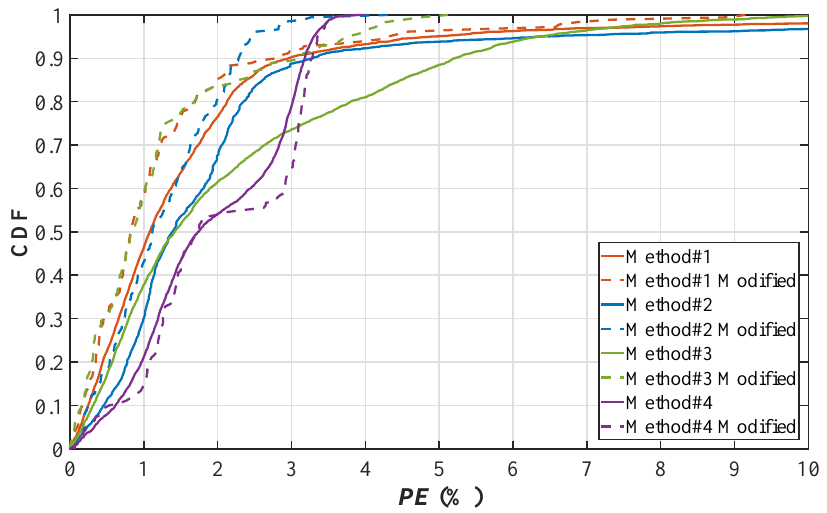
Figure 12. CDFs of PE for the conventional and the modified implementations of the examined methods.